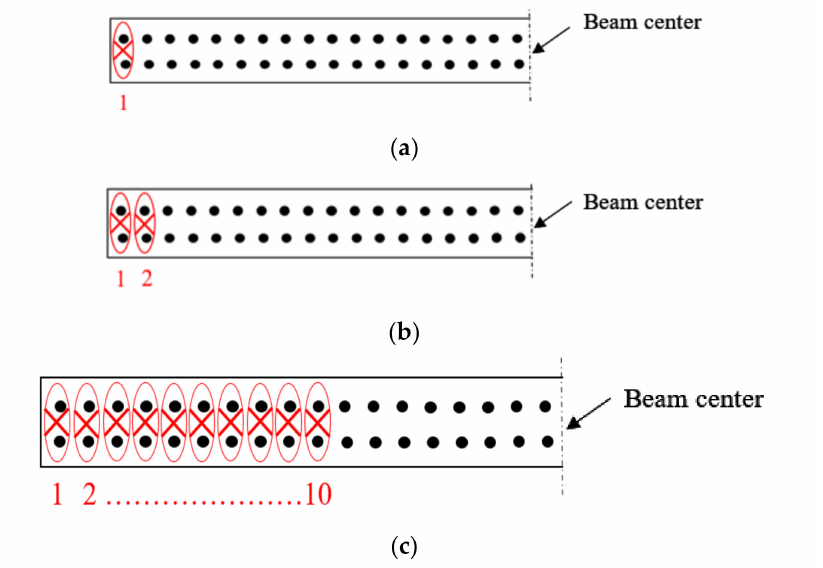
Figure 6. Top view of the steel beam showing examples of removed rows. ( a ) Step 1 (removal of one row). ( b ) Step 2 (removal of two rows). ( c ) Step 10 (removal of 10